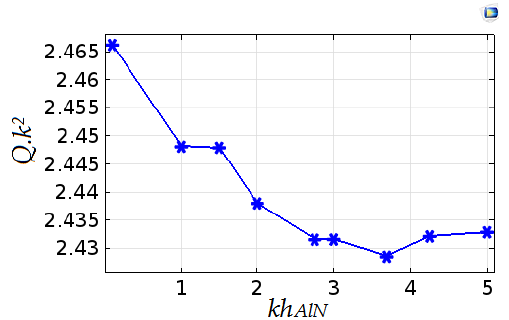
Figure 6 . Figure of merit ( Q.k 2 ) versus kh AlN . Figure 6. Figure of merit ( Q.k 2 ) versus kh